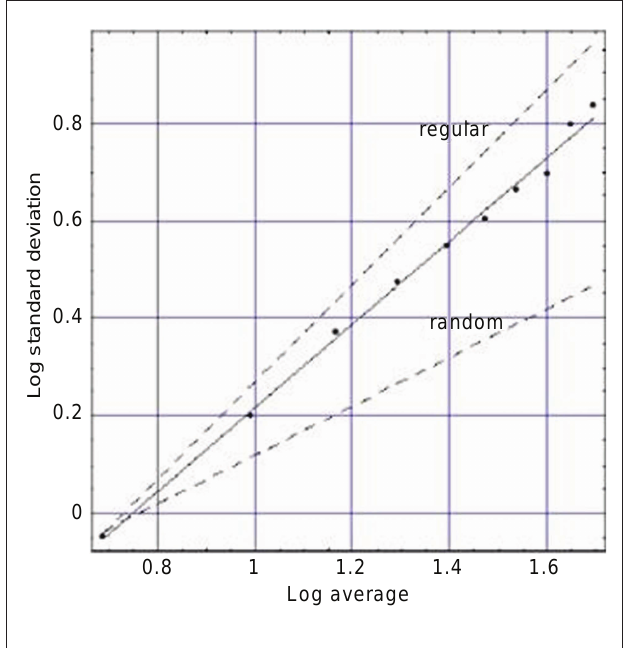
Figure 3 | A fit to the aggregated standard deviation versus the aggregated mean for a typical BrV time series (West, 2006a) is depicted. The points are calculated from the data and the solid curve is the best least-square fit to the processed BRV data and yields a fractal dimension D = 1.14 midway between the curve for a regular process ( D = 1) and that for an uncorrelated random process ( D = 1.5) as indicated by the dashed curves.